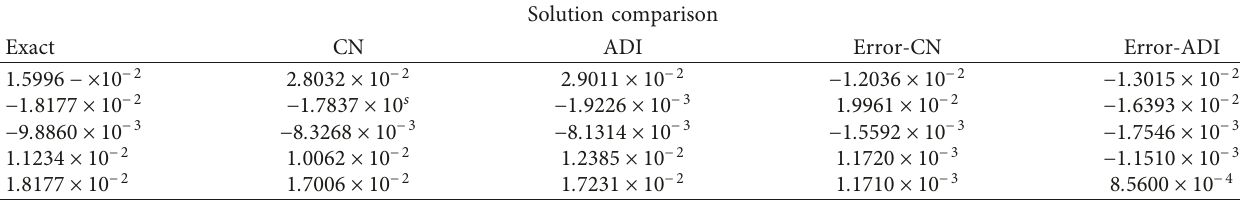
Table 1: Evaluation of approximate and exact results of ADI and CN at t � 0.1 for unknown u ( p,q,t ) . Numerical solution at ϵ � 0 . 1 ,k � 0 . 001 , gridsize � 10 × 10.